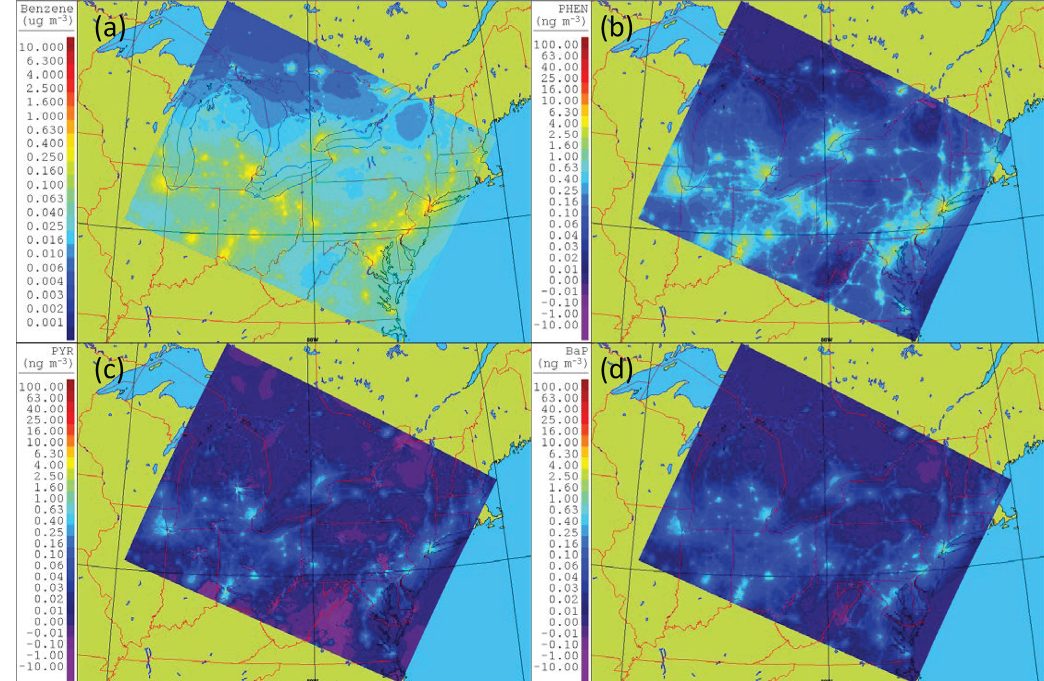
Figure 3. Seasonal-average absolute on-road vehicle contributions for (a) BENZ, (b) PHEN, (c) PYR, and (d) BaP in the